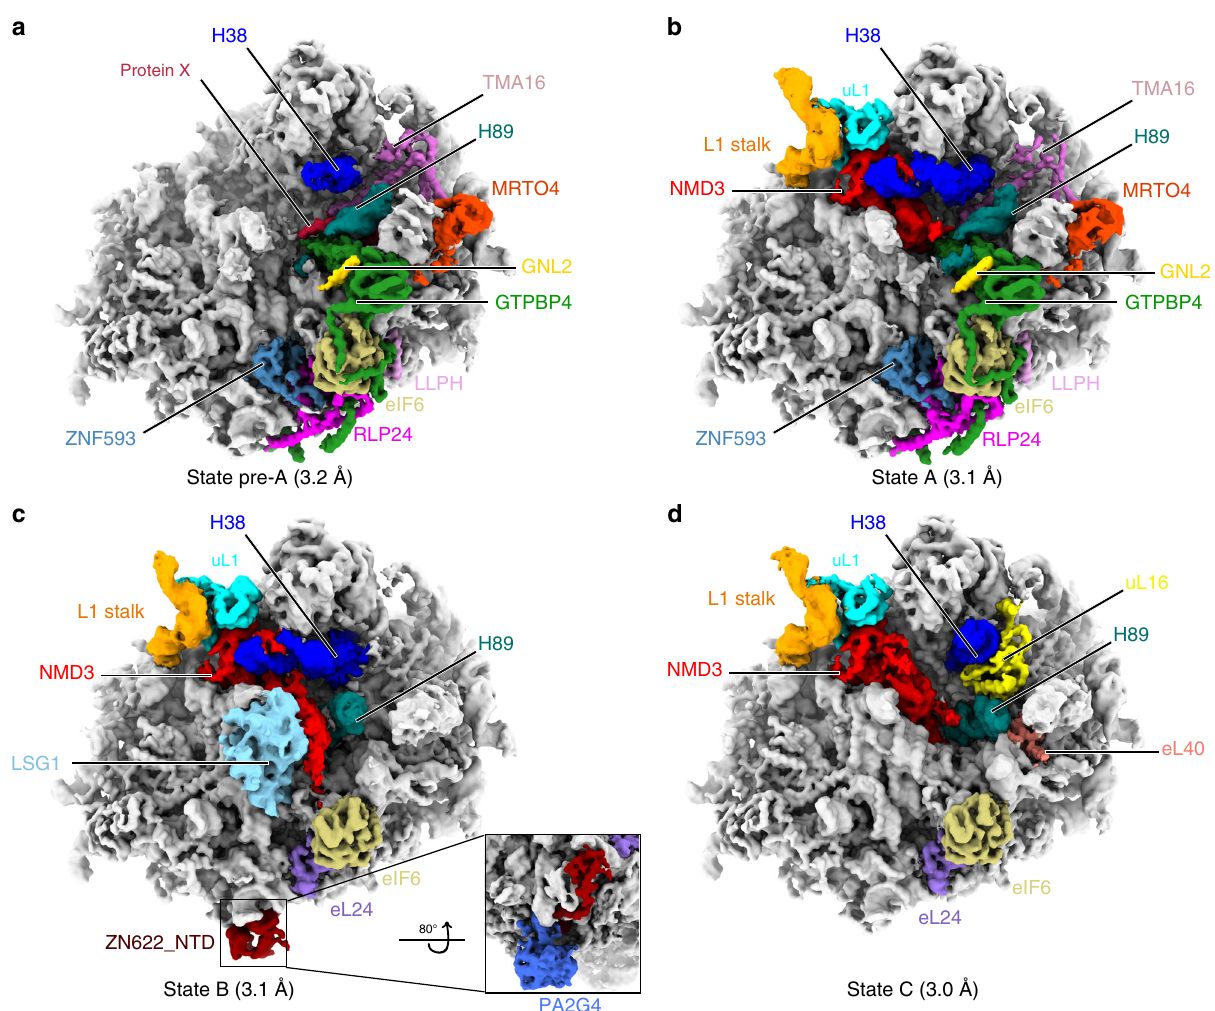
Fig. 1 Structures of human pre-60S particles isolated through C-terminally tagged NMD3. a – d , Cryo-EM maps of the four structures of NMD3-particles from pre-A to C, gaussian fi ltered with sDev of 1.058 Å in ChimeraX 70 . Individual assembly factors, H38, H89, L1 stalk, eL24, eL40 and uL1 are color-coded. Below each map, the overall resolution is